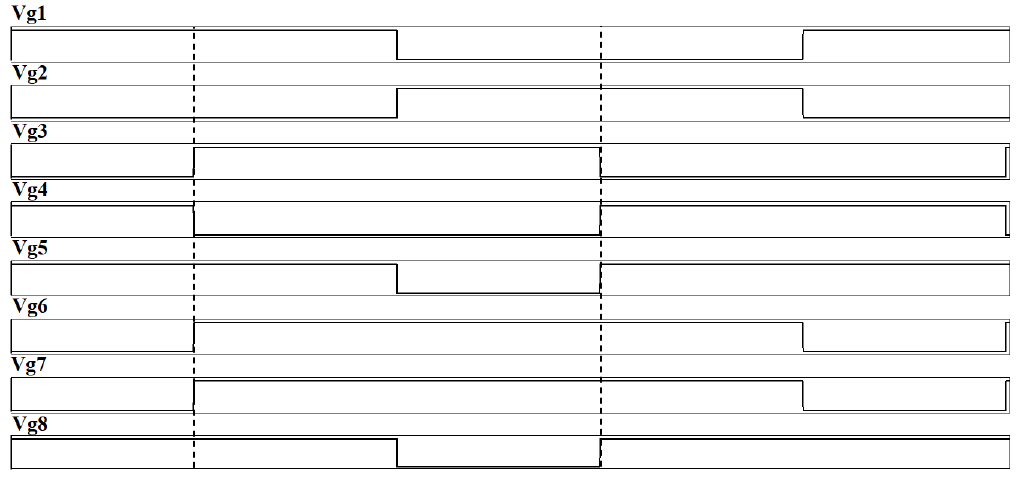
Figure 5. Gate signals in conventional PSM.